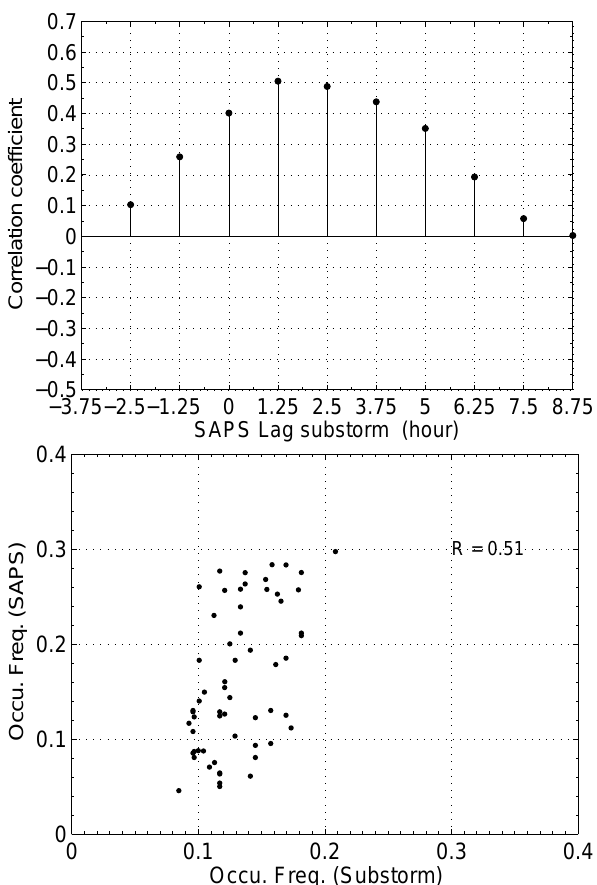
Fig. 5. Correlation between substorm onset and the start of SAPS. Left: cross-correlation coefficients as function of lag time. Right: correlation study of the occurrence of substorm and SAID with 1.25h time delay.